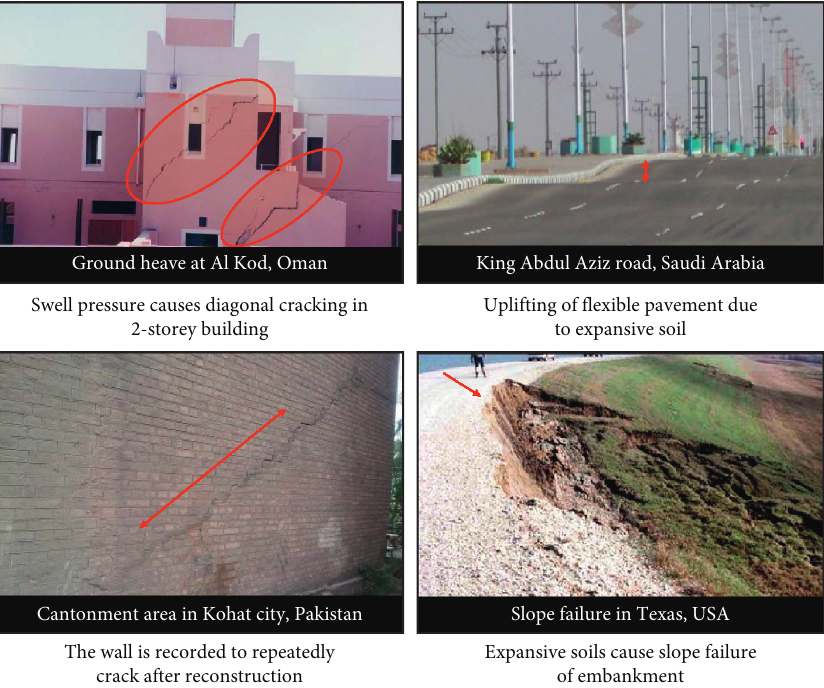
Figure 3: Expansive soil damage to civil engineering infrastructure across Oman, KSA, Pakistan, and USA (with some changes for comparison purpose) [62, 69–71].